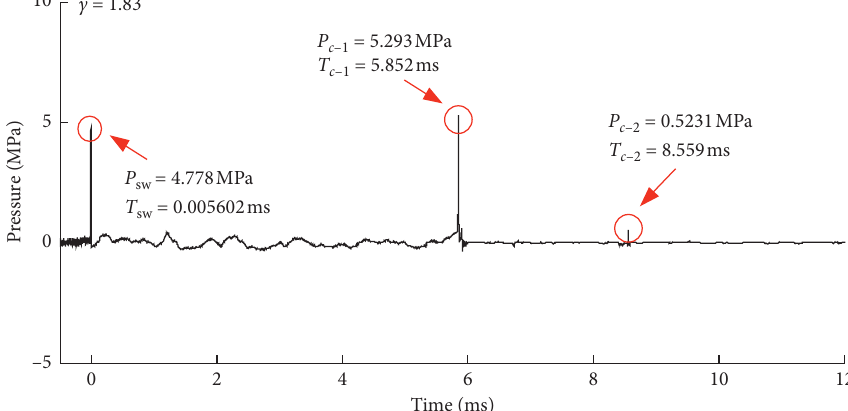
Figure 36: Pressure-time diagram of the first and second cycles of the spark-generated bubble load for c � 1.67. γ = 1.83